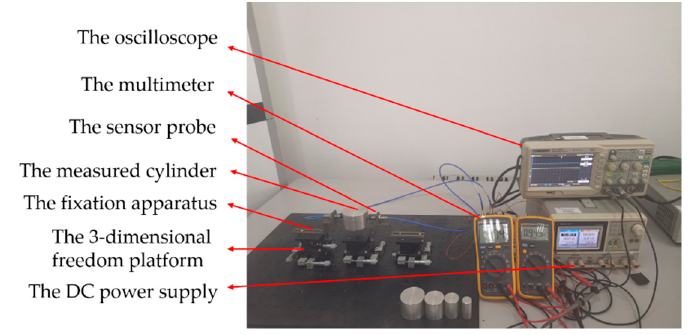
Figure 23. The differential structure eccentric experimental platform. Figure 23. The di ff erential structure eccentric experimental platform.